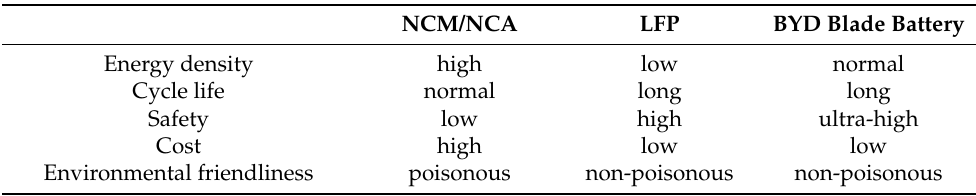
Table 3. Batteries